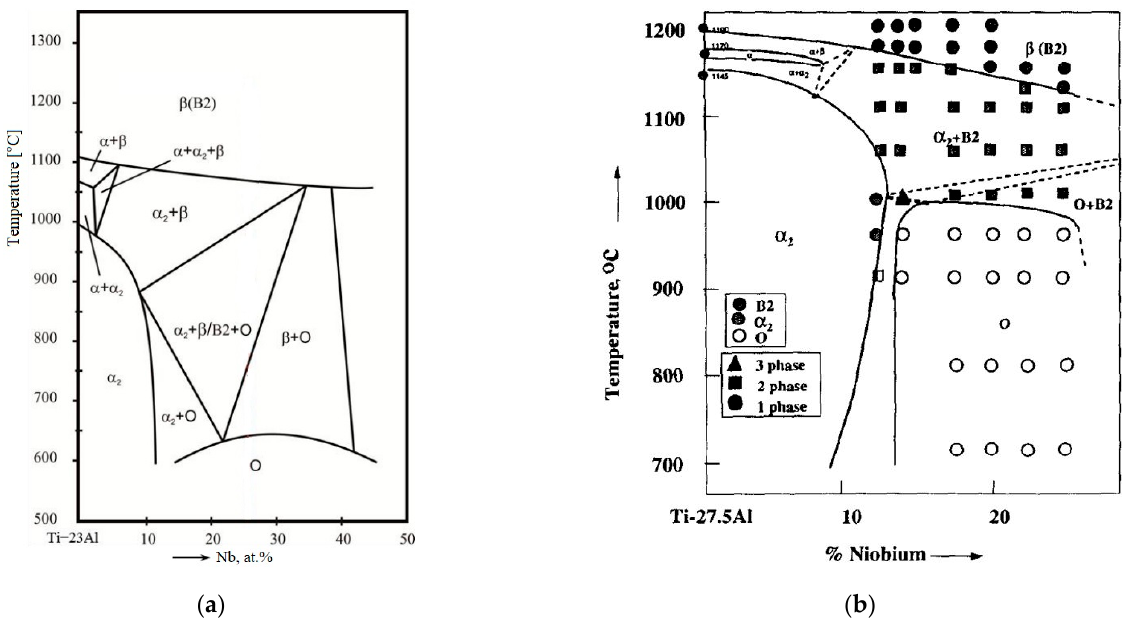
Figure 2. Isopleth sections of the ( a ) ternary Ti-23%Al-xNb diagram [22] and ( b ) Ti-27.5% Al-xNb. Diagram reproduced with permission from Elsevier [24].